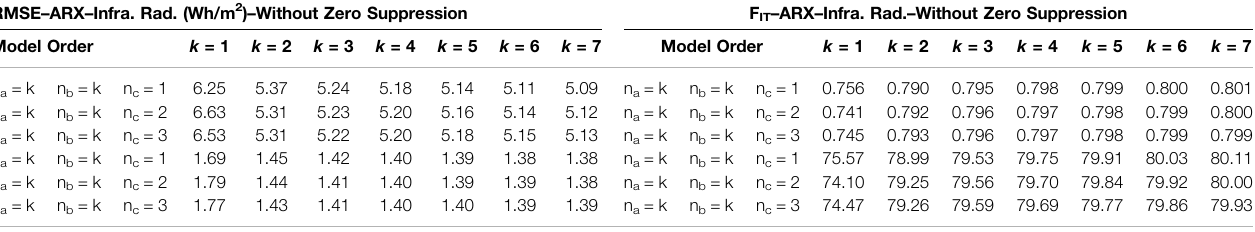
TABLE 3 | RMSE and F IT values for horizontal infrared horizontal radiation model ARX. RMSE – ARX – Infra. Rad. (Wh/m 2 ) – Without Zero Suppression F IT – ARX – Infra. Rad. – Without Zero Suppression Model Order